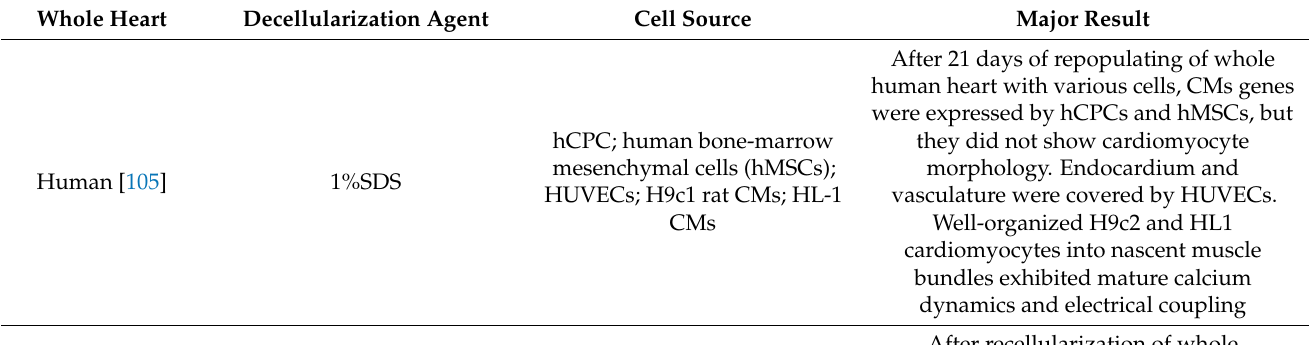
Table 3. Human whole-heart